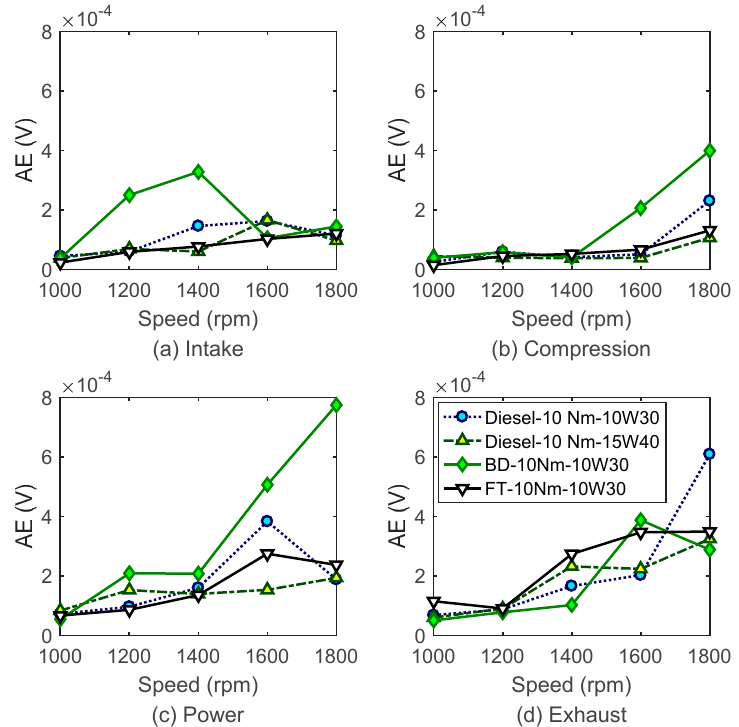
Figure 14. Asperity–asperity–collision acoustic emission (AAC–AE) indicators of different alternative fuels under low load: ( a ) Intake; ( b ) Compression; ( c ) Power; ( d ) Exhaust.